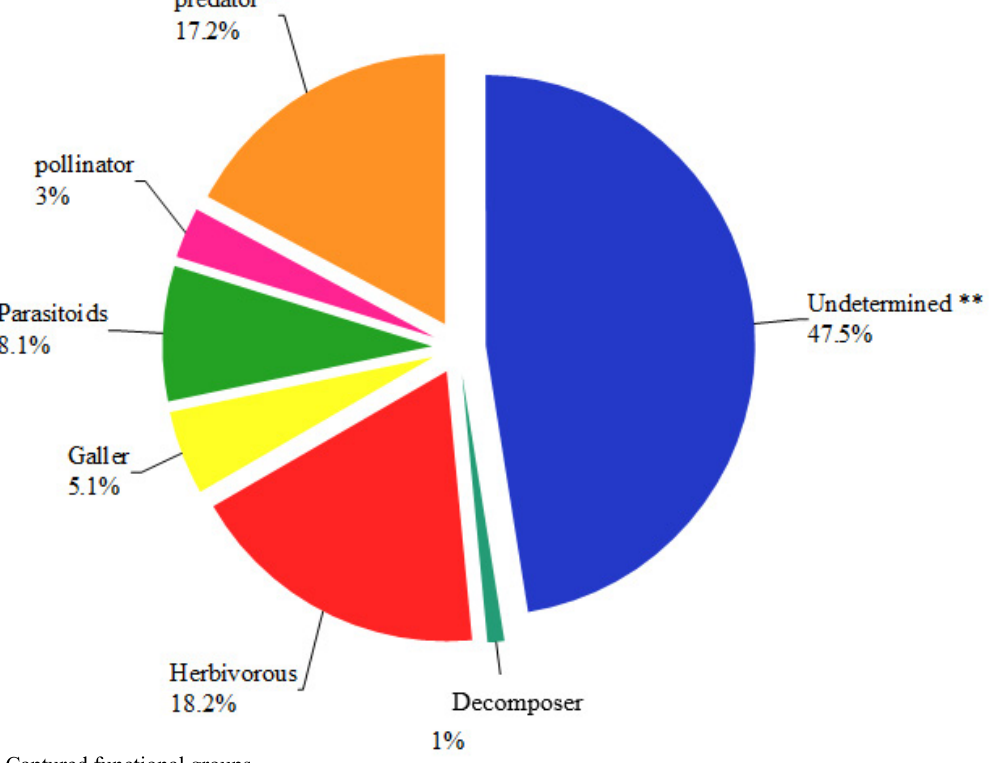
Fig 3. Proportion of the 3,875 individuals captured according to the functional group to which they belong. The collections were carried out in 18 localities of organic vegetable production in the Rashad, Sudan , from February to June 2020 and February to May 2021, using 360 universal collectors and 360 yellow adhesive trap